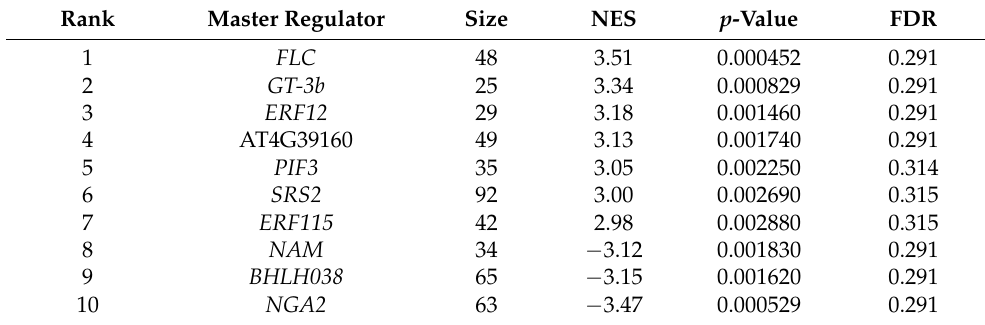
Table 6. Top 10 Master Regulators between wild type and lnk1/lnk2 mutant predicted by